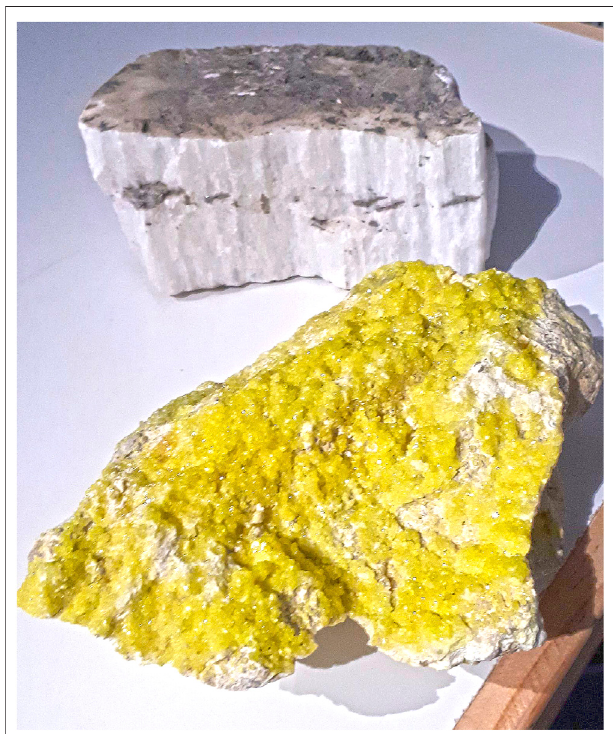
FIGURE 1 | Sulfur and a rock of sulfate. A lump of elementary sulfur featuring many shades of sulfuric yellows (front) and a rock of gypsum (rear), (cid:129) also known as CaSO 4 2 H 2 O. Both specimens were kindly provided by the Lapworth Museum of Geology, University of Birmingham, for an outreach event (to